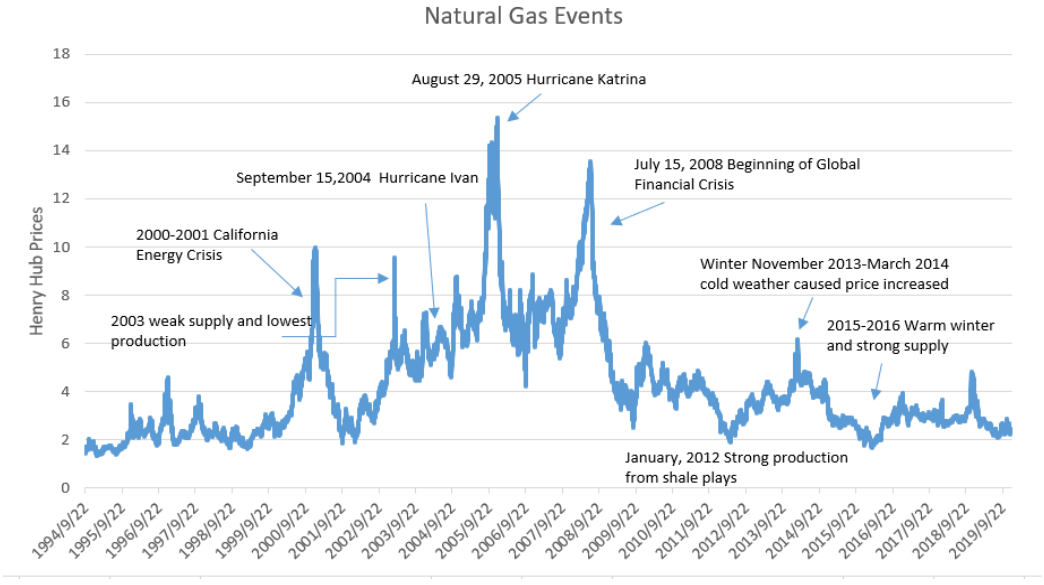
Figure 1. The major crisis events related to US natural gas.